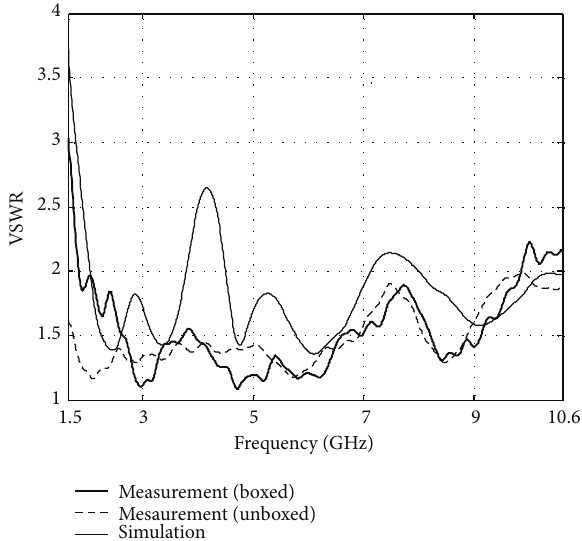
Figure 7: Simulated and measured (for both boxed and unboxed cases) VSWR plot of the antenna.